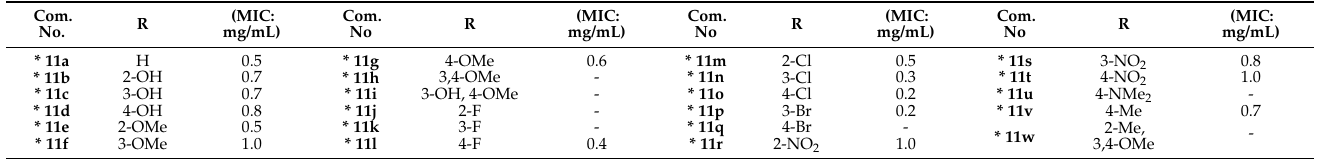
Table 19. Antibacterial activities of tested chalcones against B. bronchiseptica